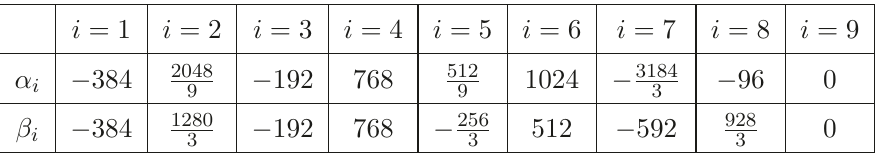
Table 2 . Our choice of the coefficients in the field